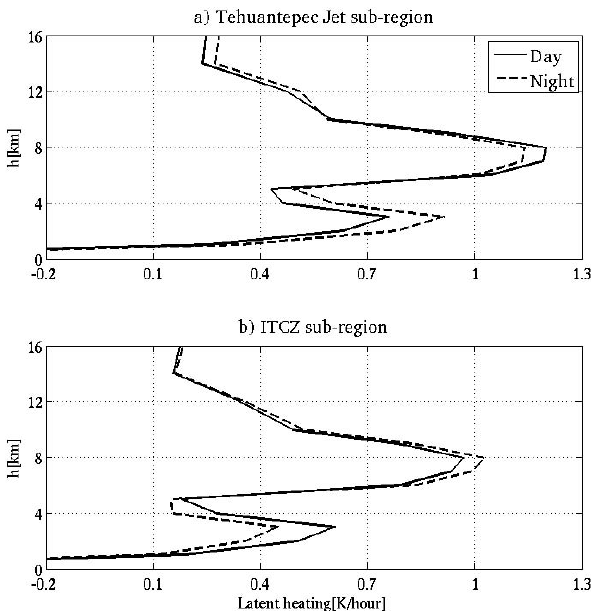
Fig. 8. Vertical profiles of the latent heating averaged over four sum- mer months (June to September) for the period 2005–2009, and spatially averaged over the sub-regions: (a) Tehuantepec Jet and (b) ITCZ. Solid lines correspond to daytime profiles (06:00a.m.– 06:00p.m.) and dashed lines correspond to nighttime profiles (06:00p.m.–06:00a.m.).